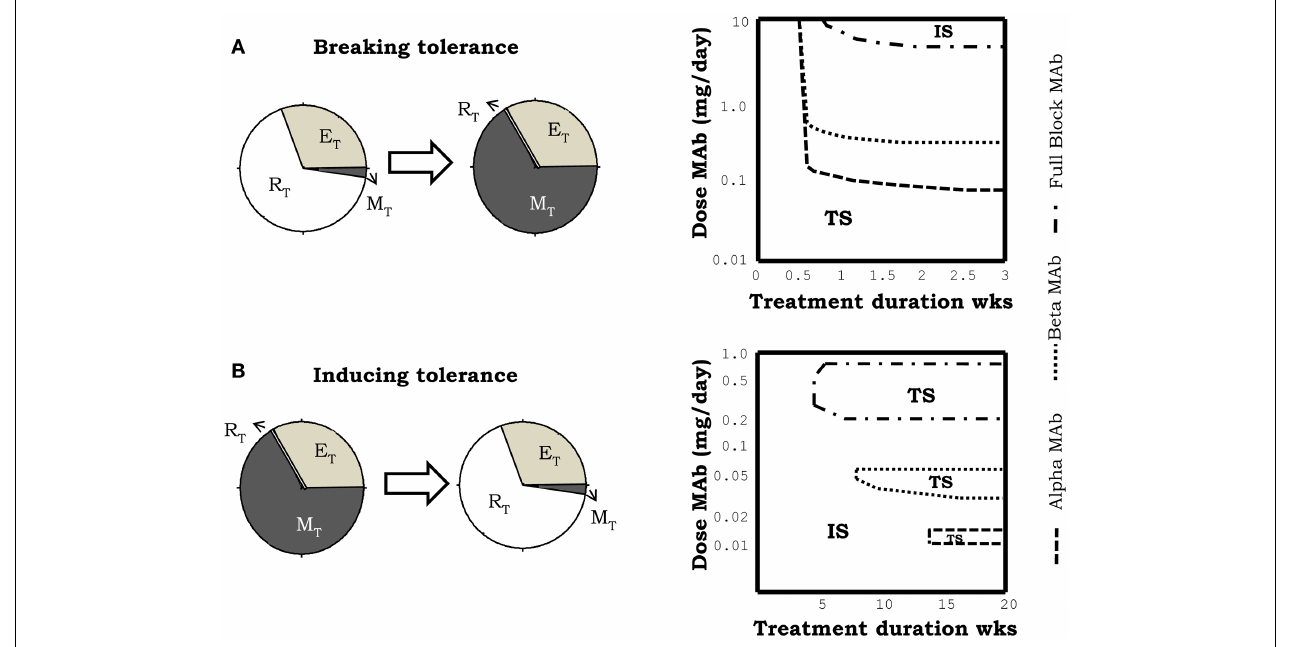
in the autoimmune steady state. Breakdown of a preexistent tolerant state requires a minimal effective dose of mAb and treatment duration [graph in the right side of (A) ]. In this scenario, face alpha mAbs are more efficient than face beta or fully blocking mAb.This means that the latter need higher doses of mAb to achieve a similar effect. Induction of tolerance requires minimum treatment duration with a mAb dose inside an intermediate window of values [graph in the right side of (B) ].This effect is obtained when face alpha, face beta, or fully blocking mAbs are